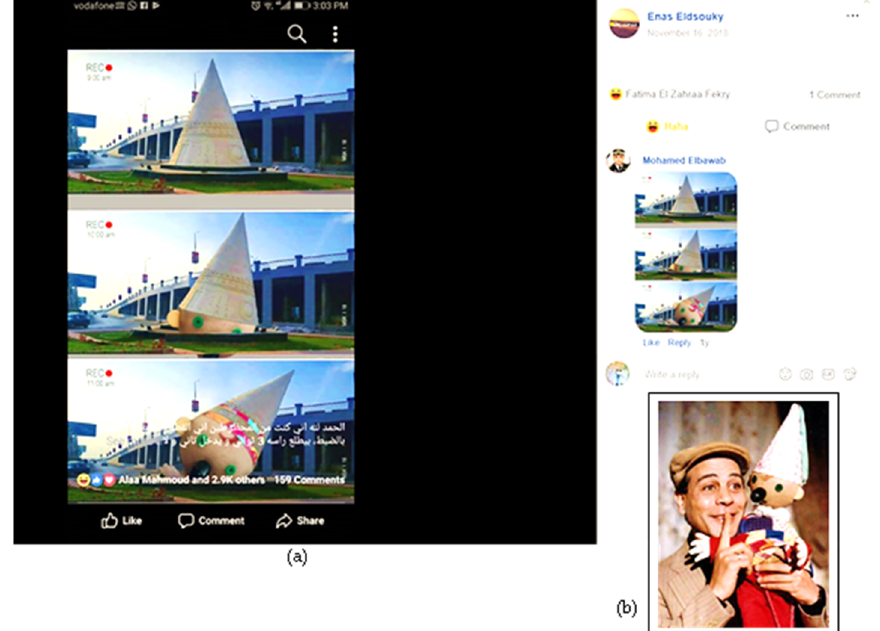
Figure 6. A screenshot of one of the Facebook group comments about these two photographs with the same angle of view. The main comment by Shehab Ahmed Helmy says, ‘The area before and after, and no words can describe this scene’. Source: F. Hussein.